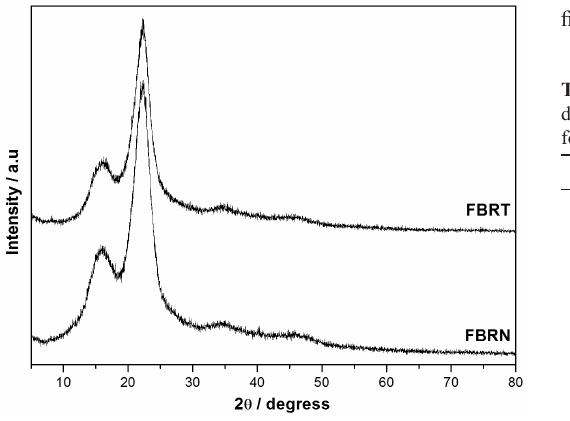
Figure 4. XRD curves of purple banana fibers in natura and treated.